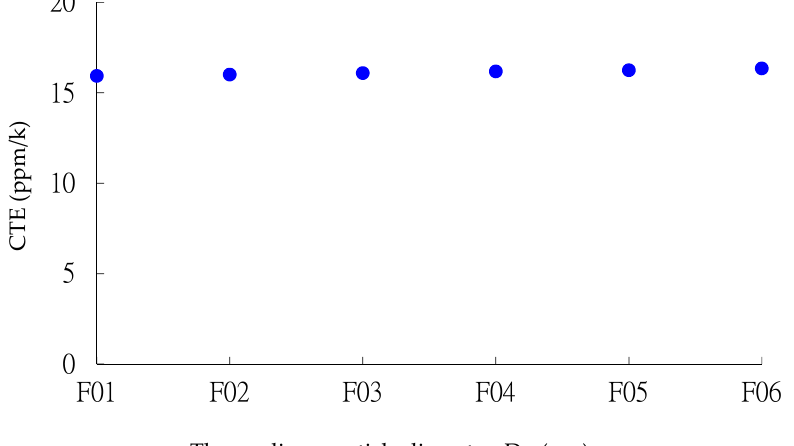
Figure 8. Coefficient of thermal expansion (CTE) versus D50 for polygonal fused silica ( σ : 0.004 ppm/K–0.030 ppm/K).